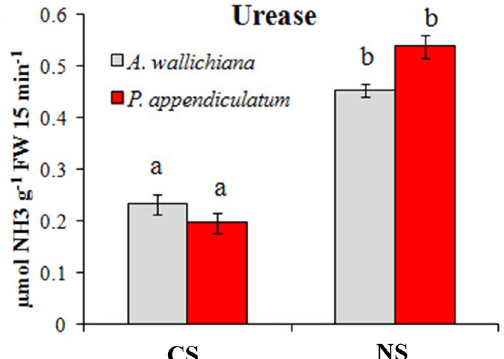
Figure 5. Nickel modulates urease enzyme activity. (a) Urease enzyme activity [µmol NH 3 g -1 fresh weight (FW tissue) 15 min -1 ] in thalli of A. wallichiana and P. appendiculatum grown in control site (CS, n = 5) and Ni-excess site (NS, n = 5). Data presented are means ± standard errors ( n = 5). Different letters (a & b) indicate significant differences from each other in all combinations (Tukey’s test, P ≤